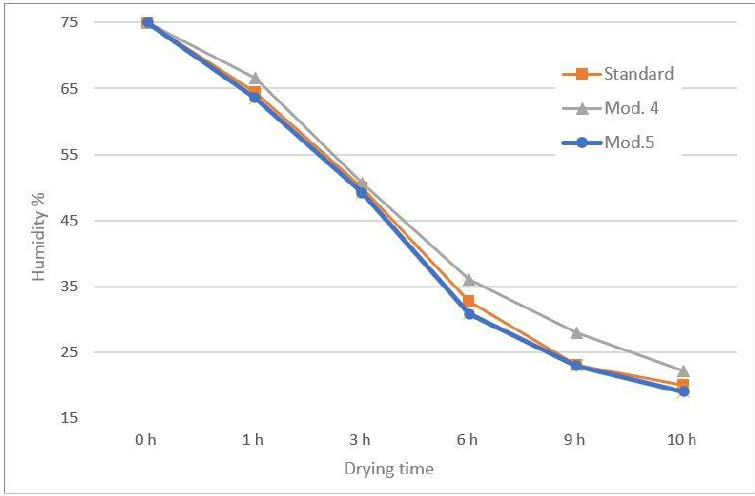
Figure 15. Drying curve—product moisture in chamber 5.